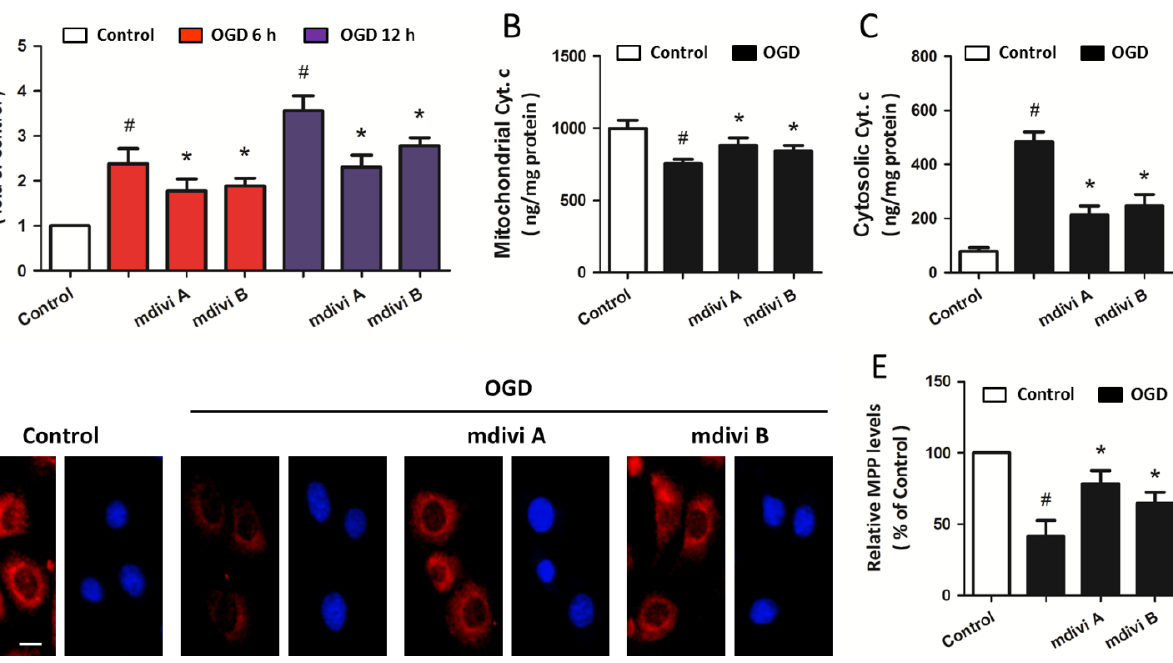
Figure 3. Drp-1 inhibitors attenuate mitochondrial dysfunction. PC12 cells were pretreated with mdivi A (50 μM) or mdivi B (50 μM) for 30 min before OGD injury. Intracellular ROS levels were measured at 6 and 12 h after OGD initiation ( A ); release of cytochrome c into the cytoplasm was determined by an immunoassay kit after subcellular fraction preparation ( B , C ); The loss of mitochondrial membrane potential (MMP) was determined by Rh123 staining ( D ) and calculated ( E ). Scale bar: 10 μm. The data were represented as means ± SD from five experiments. # p < 0.05 vs. control. * p < 0.05 vs.